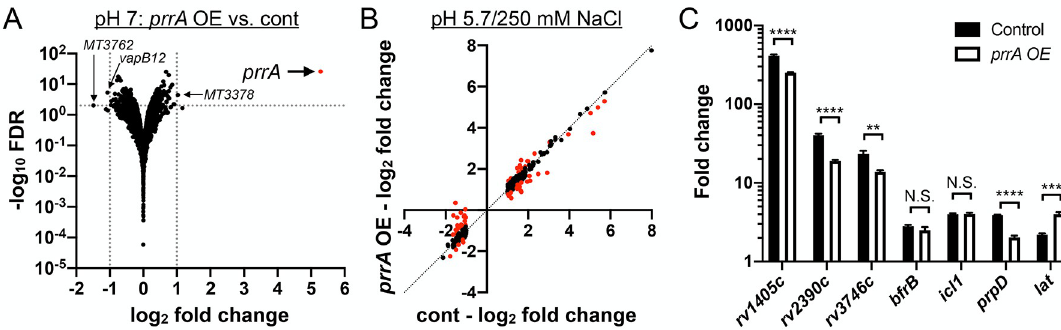
Fig 2. Perturbation of PrrA globally alters Mtb response to pH and Cl - . (A) prrA overexpression does not significantly alter Mtb transcriptional profile in standard pH 7.0 growth conditions. Mtb(P 1 ’:: prrA -FLAG - tetON, rv2390c’ ::luciferase) was grown in 7H9, pH 7.0 media and treated with 0.1% EtOH or 200 ng/ml ATC for 6 hours before RNA was extracted for RNA sequencing analysis. Log 2 -fold change compares gene expression in the ATC (“ prrA OE”) versus EtOH (“cont”) treatment sets. (B and C) prrA overexpression